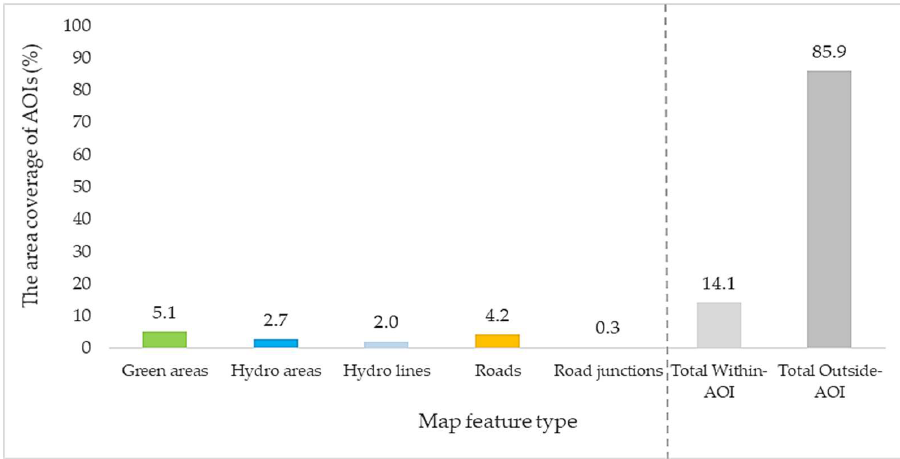
Figure 5. The area coverage of AOIs (%) based on the map feature type. Together, within- and outside-AOIs cover the entire screen (100%) as shown on the right-most two bars.